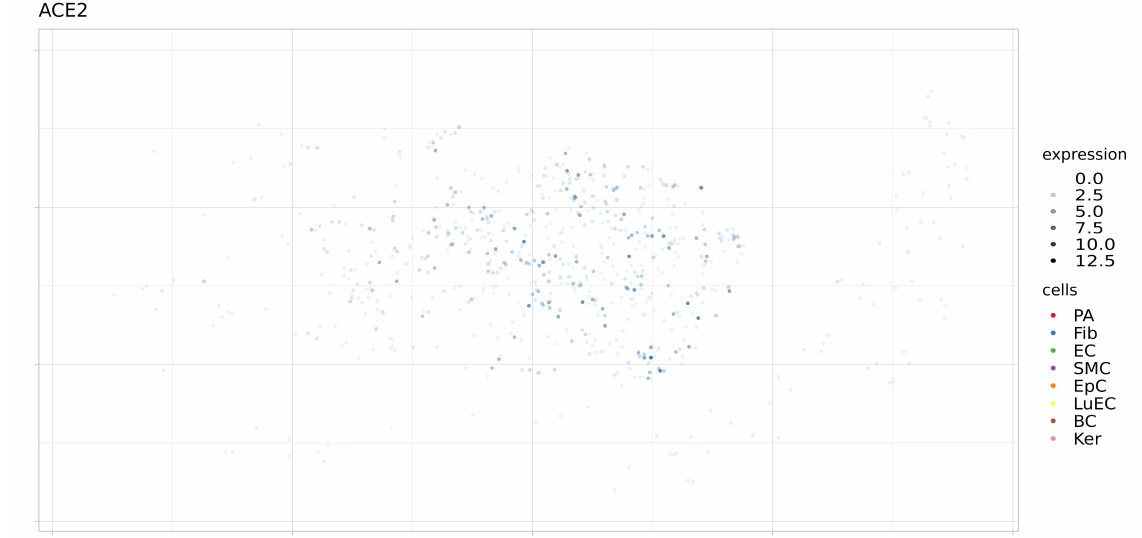
Figure 7. Expression levels ACE2 in separate cells of proximal stromal lung (SRS2769051). PA, pulmonary alveolar type II cells; Fib, fibroblasts; EC, endothelial cells; SMC, smooth muscle cells; LuEC, luminal epithelial cells; BC, basal cells; Ker, keratinocytes. Color intensity indicates the level of expression in a single cell.